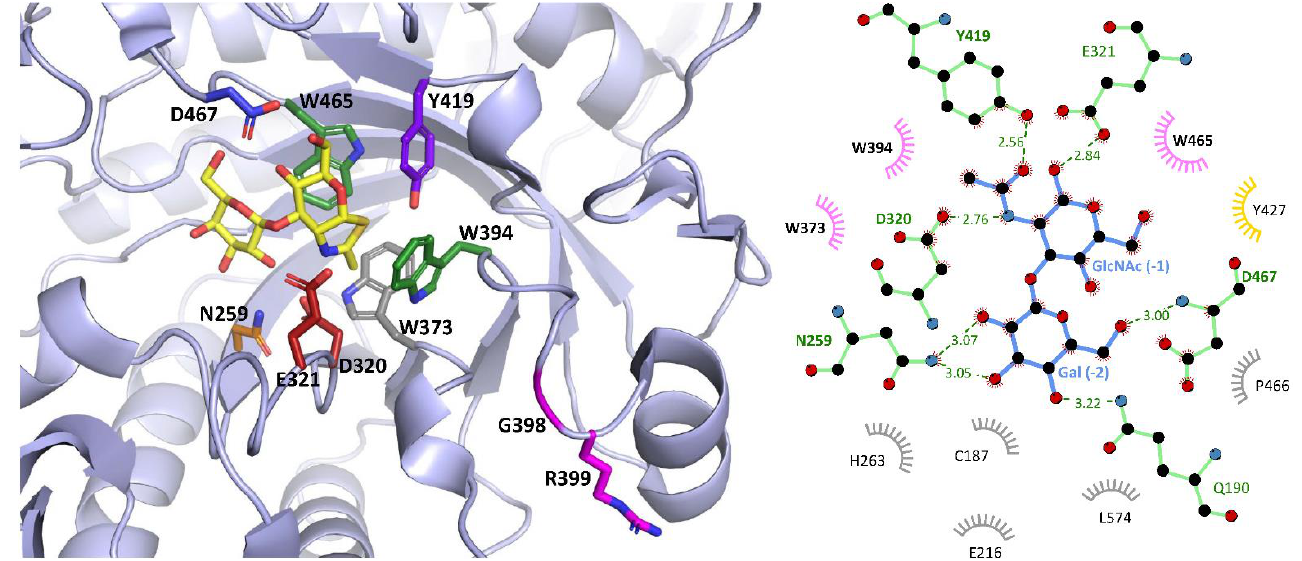
Figure 3. ( Left panel ) : Zoom of the active site in LnbB (light blue) in complex with LNB-thiazoline (yellow; PDB 4JAW [7]) highlighting catalytic residues D320 and E321 (red) and other residues targeted for mutation to improve transglycosylation. The residue coloring matches that of the multiple sequence alignment in Figure 2. ( Right panel ): Two-dimensional map of the interactions between LnbB and the LNB ligand based on the crystal structure of this complex (PDB 4H04 [7]). Blue line: LNB bonds. Light-green line: residue bonds involved in the formation of hydrogen bonds with the ligand. Dotted green line: hydrogen bonds labelled with their length (Å). Half sun: residues involved in hydrophobic contact with the ligand (pink half sun: Trp residues of subsite − 1 belonging to the hydrophobic platform; yellow half-sun: other residues of subsite − 1; grey half sun: residues of subsite − 2). Amino acids subjected to mutation in the current work are highlighted in bold. Table 1. Maximum yields of LNT and of LNT plus isomers (listed as total transglycosylation products; TG) from trans- glycosylation reactions by LnbB WT and variants, using LNB-oxazoline as donor and lactose as acceptor and 1 µ M of enzyme at pH 7.4 and 37 ◦ C. Superscript letters ( a–i ) indicate statistically significant difference between the values within the column ( p < 0.05). The time at which the maximum transglycosylation yields are reached is indicated (samples taken after 0.25, 3, and 24 h of reaction). Secondary hydrolysis is indicated as the percentage of LNT, which was hydrolyzed after 24 h of reaction (calculated as (max. LNT yield − LNT yield at 24 h]/[max. LNT yield)). An asterisk (*) indicates that the LNT concentration after 24 h is not significantly different from the maximum yield (secondary hydrolysis not statistically significant; p < 0.05). Regioselectivity is indicated by the percentage of total transglycosylation products (TG), which is identified as LNT. For each column, the best results are marked in bold, whereas the second best results are underlined.